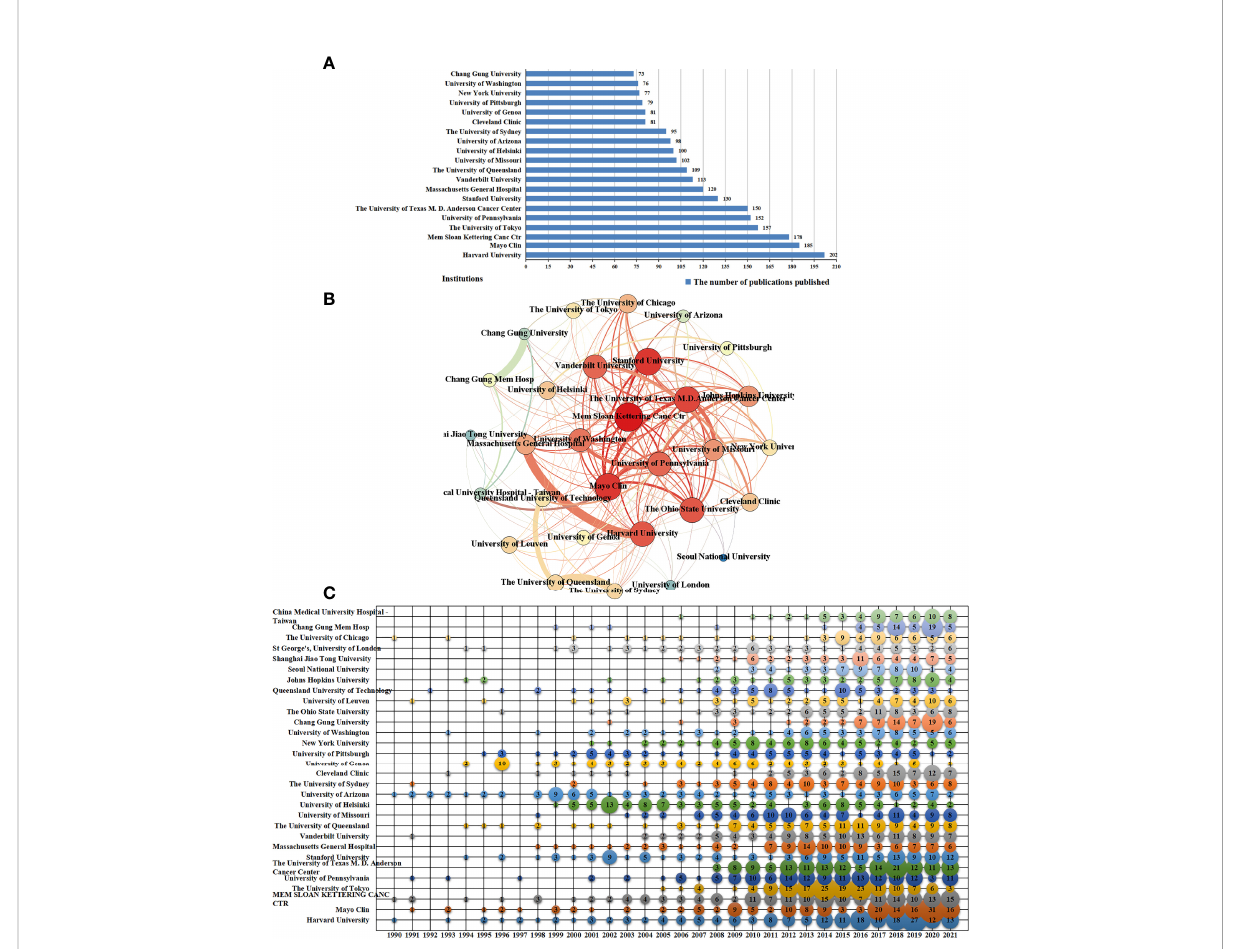
FIGURE 6 The distribution of publication output by institutions. (A) The top 20 most-productive institutions of lymphedema publications. (B) The co- authorship network of lymphedema publications among principal research institutions. (C) The temporal distribution of top 30 most-productive institutions of lymphedema